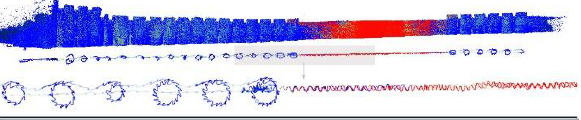
Figure 5: Trajectory of the followed path.